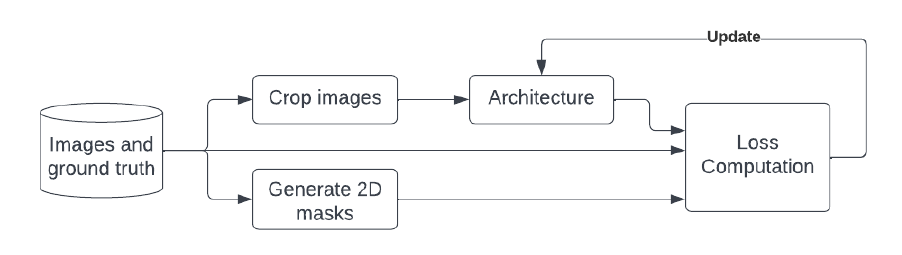
Figure 6. The proposed training